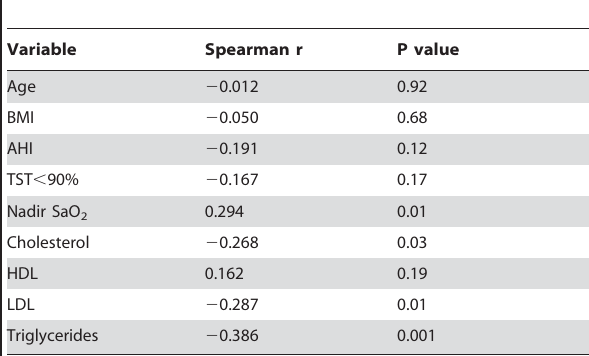
Table 3. Correlations of